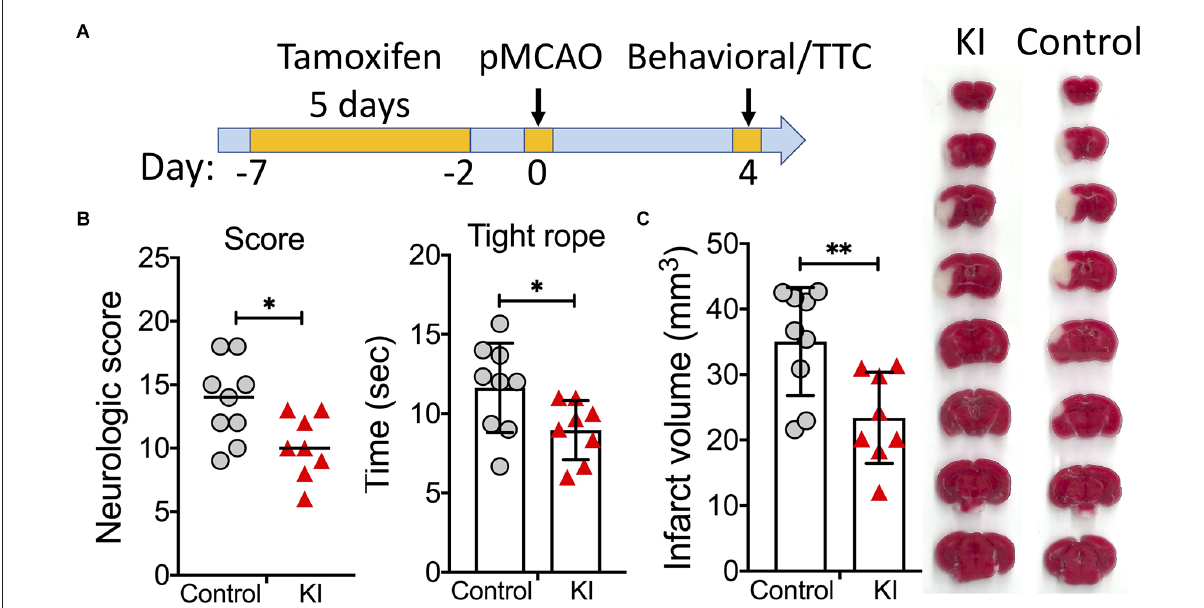
FIGURE2 Activation of the ATF6 pathway in neurons improved short-term outcome after permanent MCAO (pMCAO). (A) Experimental design. (B,C) Short-term stroke outcome. sATF6-KI (KI; n = 8) and littermate control ( n = 9) mice were subjected to pMCAO. Neurologic functions, including neurologic scoring and tight rope test, were evaluated on day 4 after stroke (B) . Then, infarct volumes were measured (C) . Representative TTC-stained brain sections are shown. Data are presented as mean ± SD or median. ∗ p < 0.05; ∗∗ p <